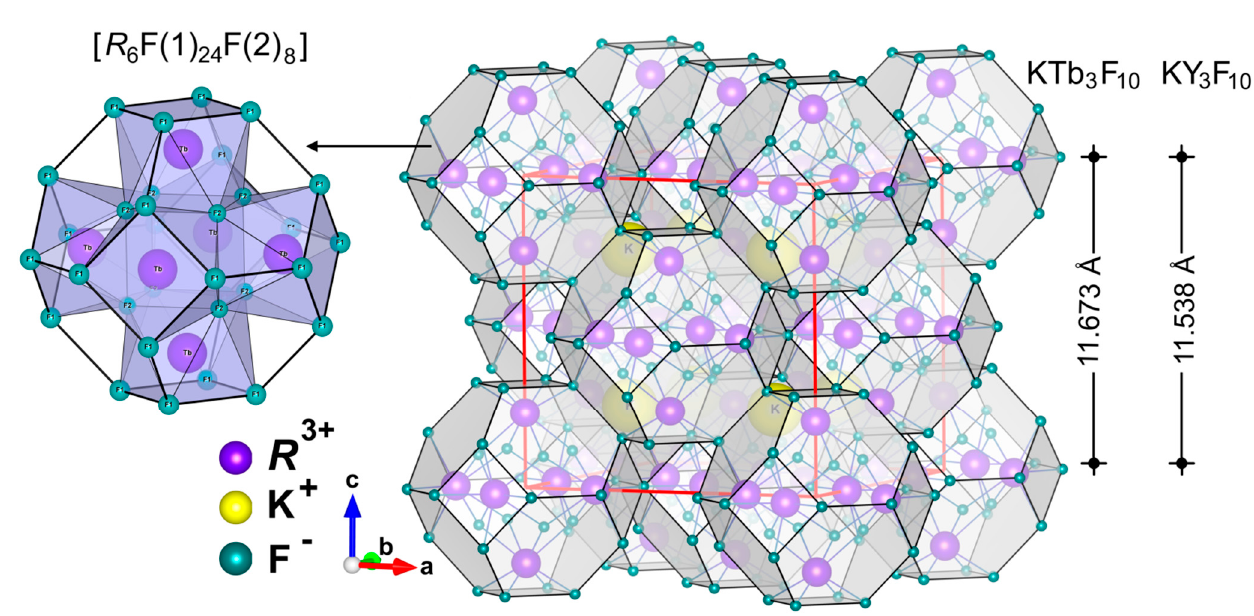
Figure 6. Geometry of the polyanionic cluster [ R 6 F 32 ] ( left ) and crystal structure of K R 3 F 10 ( R = Tb 3+ , Y 3+ ) as a three-dimensional assembly of [ R 6 F 32 ] clusters ( right ).